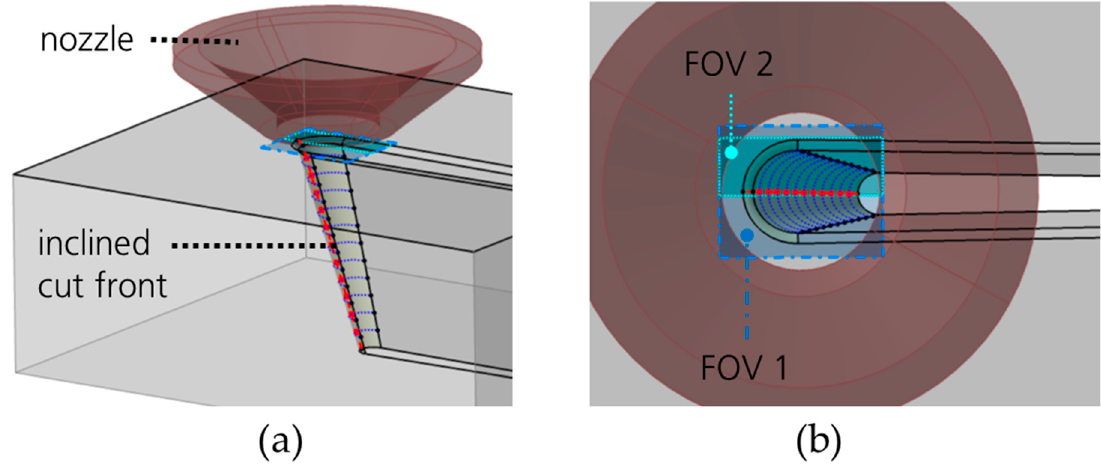
Figure 6. Principle of the camera field of view (FOV): ( a ) Perspective view of the process zone with cut kerf and front; ( b ) Top view of the cut front with camera FOVs.